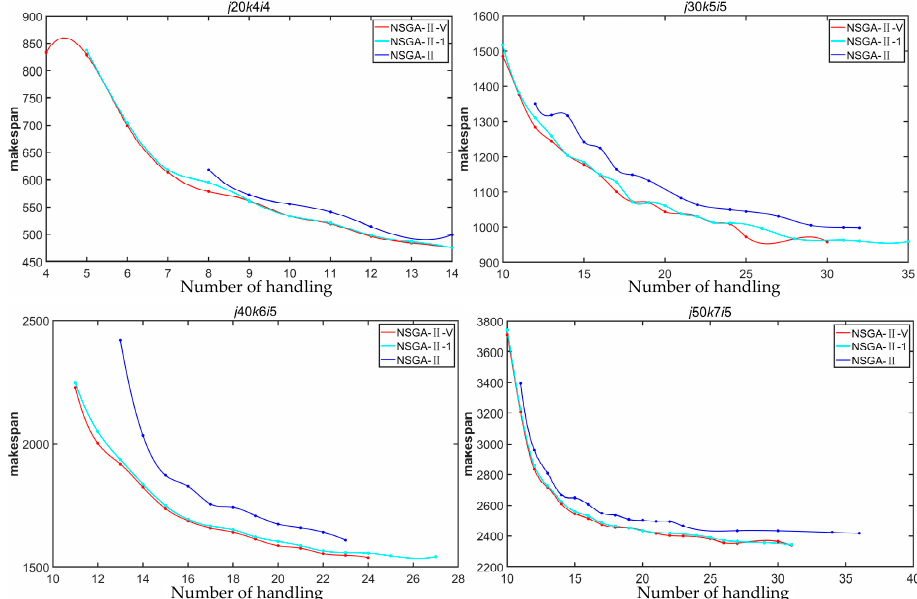
Figure 7. Pareto front distribution.